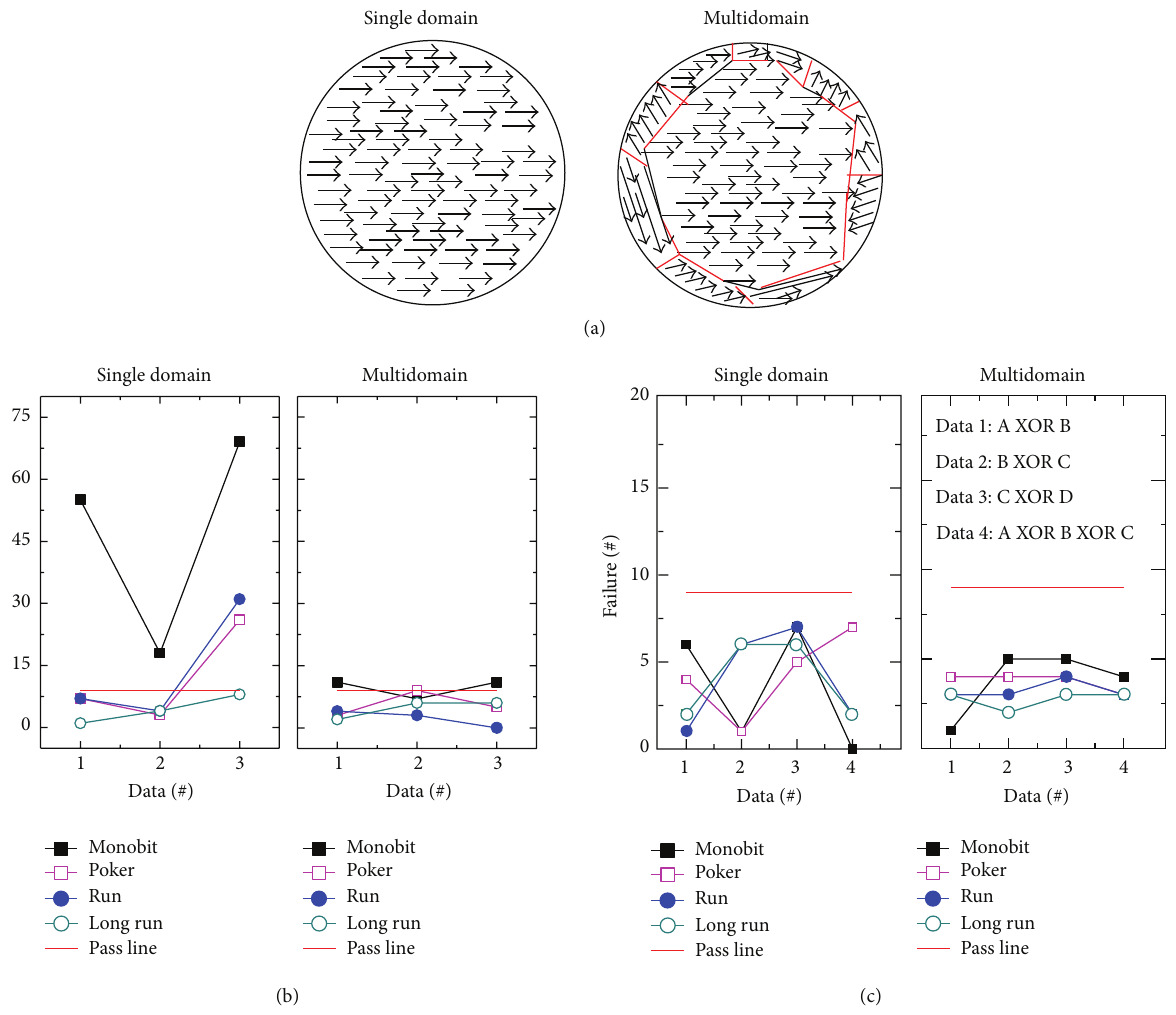
Figure 3: The randomness test for single- and multidomain pMTJ. (a) Schematic of magnetization arrangement of single- and multidomain ferromagnetic layer. The results of the randomness tests for (b) single cell data and (c) after the XOR operation. For each data set, the 2500- bit sequences are evaluated 400 times (2500 × 400 = 10 6 bits). Only nine failures are acceptable for each test (point to pass line). In the multidomain data of (b), data 1 (2, 3) means XOR of digitalized data A (B, C) and B (C, A) for 10 6 bits and data 4 means the XOR of A, B, and